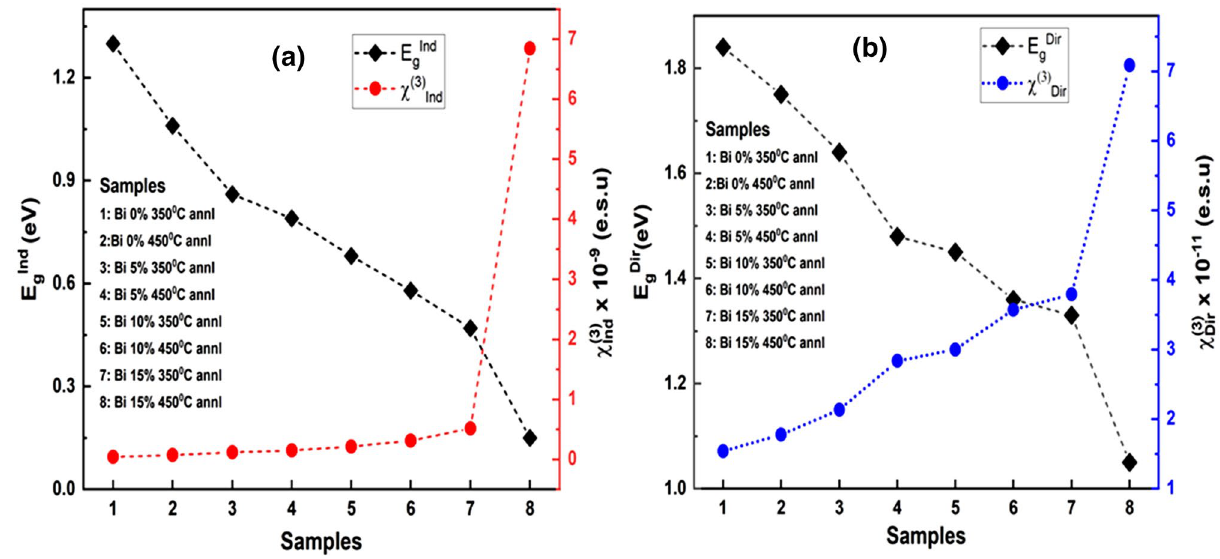
Figure 7. Variation of ( a ) E g Ind and χ (3) , ( b ) E g Dir and χ (3) with annealed